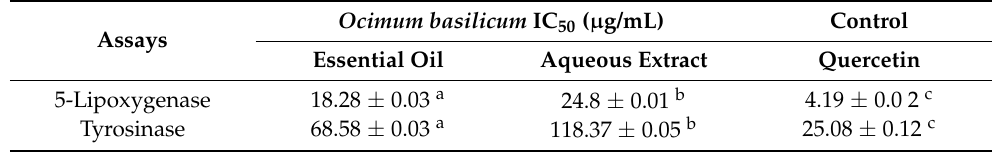
Table 7. In vitro anti-inflammatory and dermatoprotective activities of O. basilicum . Assays